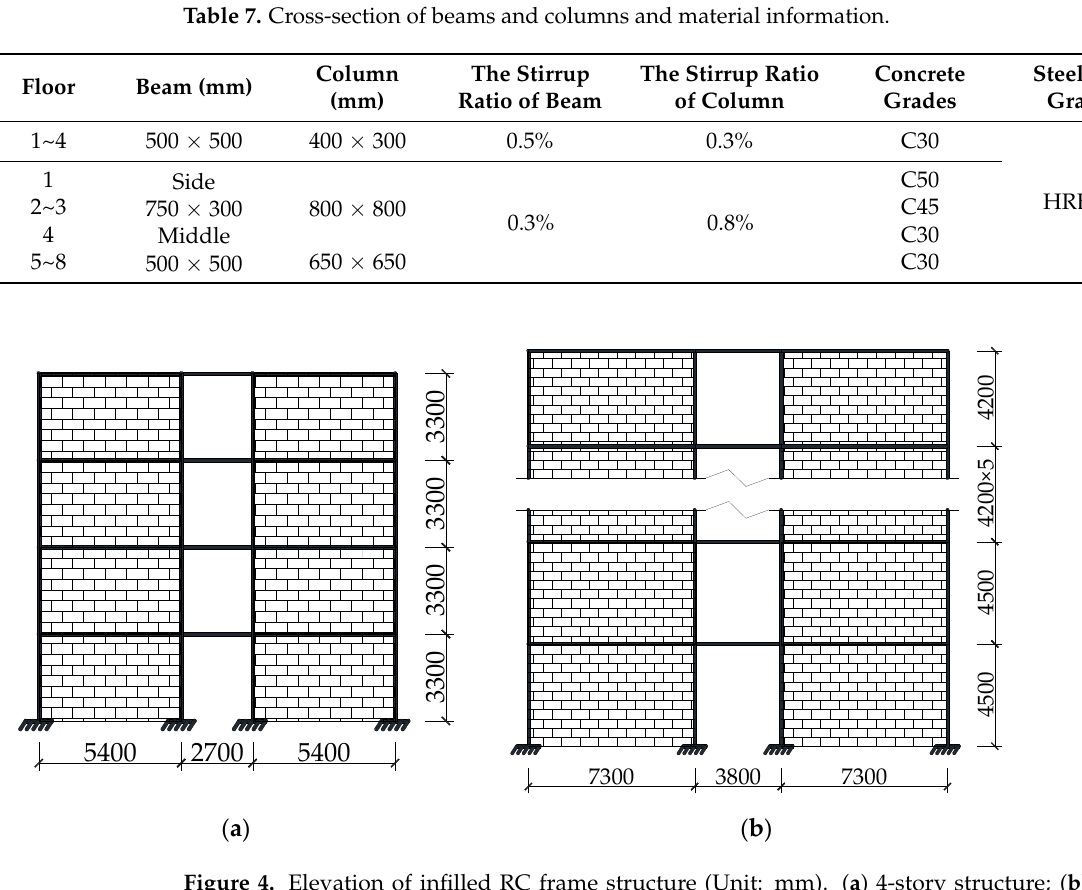
Figure 4. Elevation of infilled RC frame structure (Unit: mm). ( a ) 4-story structure; ( b ) 8-story structure.